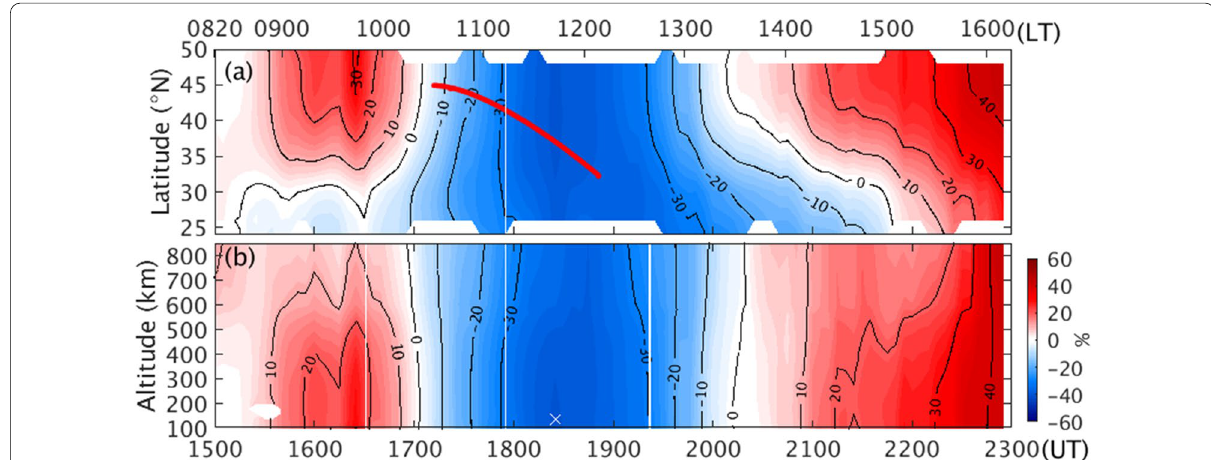
Fig. 4 The time series of electron density difference percentages at the fixed longitude of plane ( b) . The red line in a indicates the latitude and the time of the total eclipse. The white line in a indicates the time of maximum obscuration. The vertical white lines in b indicate the time of start, maximum obscuration, and end of solar eclipse. These are 1631 UT, 1755 UT, and 1922 UT, respectively. The white cross in b is denoted the altitude and the time of maximum depletion